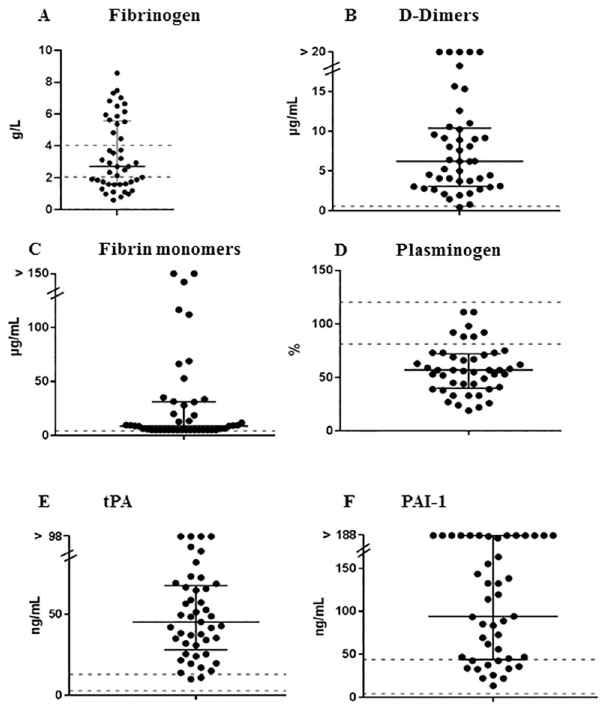
Fig 1. Investigation for fibrinolysis-related parameters in 45 patients with HLH. Each patient is represented by an icon. (A) fibrinogen; (B) D-dimers; (C) fibrin monomers; (D) plasminogen; (E) t-PA; (F) PAI-1.; normal ranges are represented as dashed lines; medians and IQR are represented as black